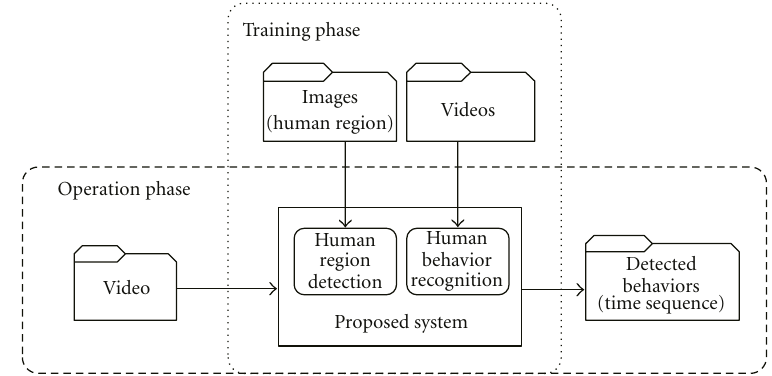
Figure 4: System configuration.